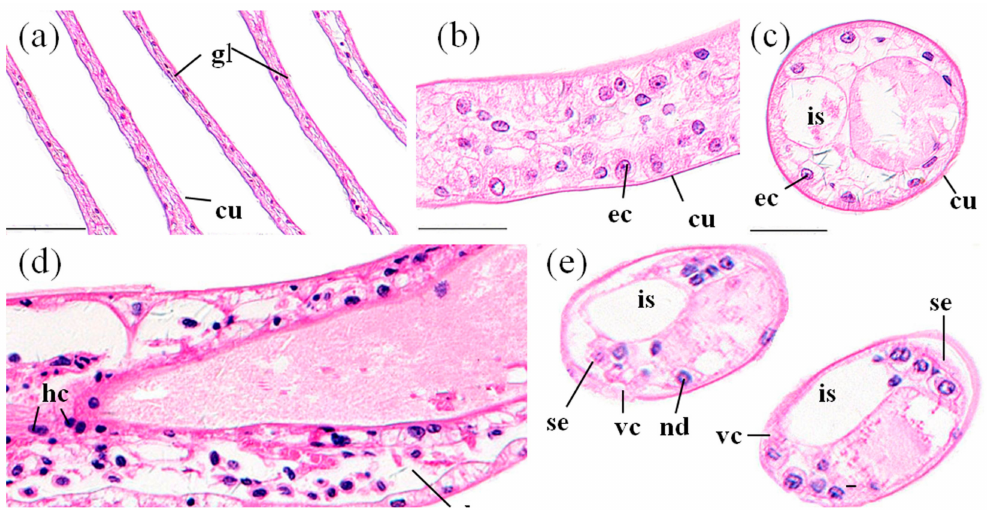
Figure 2. The gills of P. clarkii after 96 h exposure to: a control solution ( a – c ); and 72.62 mg/L MBA ( d , e ). ( a ) Control gill showed uniform gill lamella (gl) and cuticula (cu) with clear structure (200 × ). ( b ) Control gill lamella showed uniform arrangement of the gill epithelial cells (ec) (400 × ). ( c ) Control gill lamella showed uniform intralamellar space (is) (400 × ). ( d ) Damaged gill lamella exhibited granular hemocytes (hc) inside the intralamellar space, some degeneration in the cuticula (dc) and some disorganization of the gill epithelial cells (de) (400 × ). ( e ) Damaged gill lamella exhibited some vagueness of the cuticula (vc), swelling and darkening of nucleus of the gill epithelial cells (nd), and separation of some gill epithelial cells from the cuticula (se) (400 × ). cu, cuticula; ec, epithelial cell; is, intralamellar space. H&E stain, scale bars = 100 µ